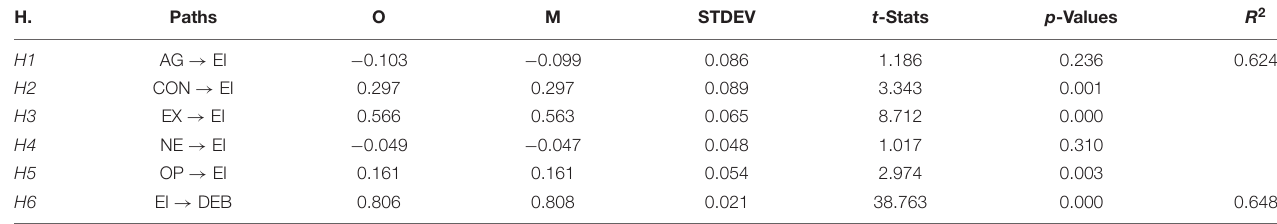
TABLE 5 | Direct effects.